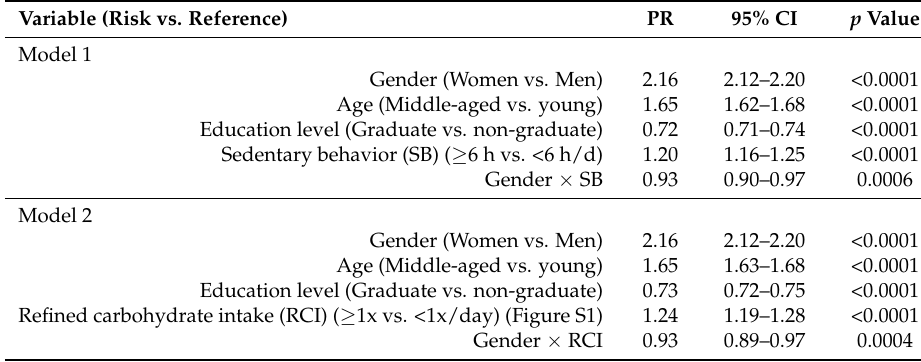
Table 3. PR of obesity with respect to sedentary behaviors, intakes of refined carbohydrates, sweet foods and beverages, and fatty and fried foods, and their interactions. Variable (Risk vs.